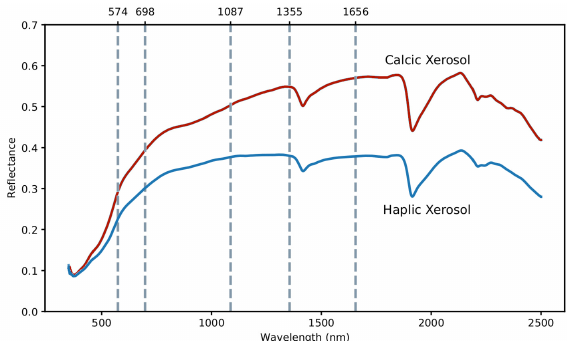
Fig. 7. Laboratory reflectance spectra of Haplic Xerosol and Calcic Xerosol used in the